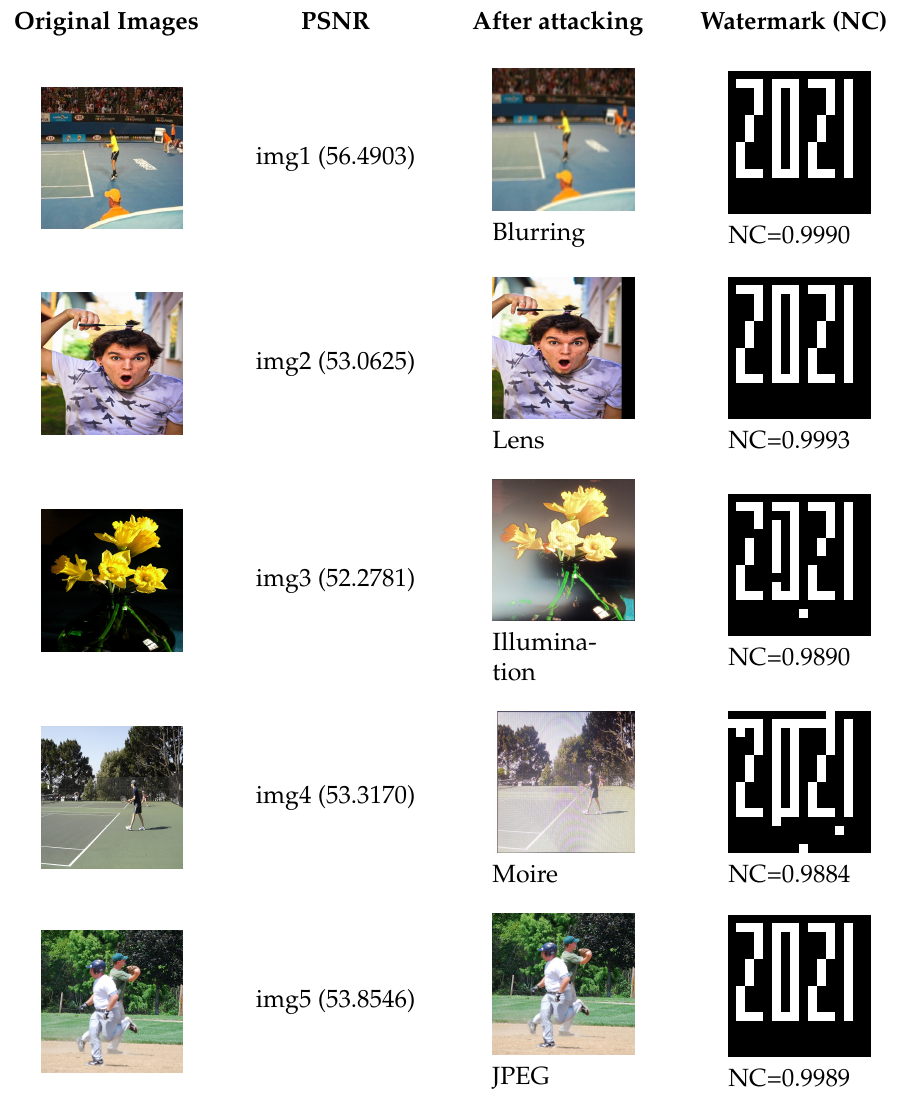
Figure 9. PSNR and NC values for different attacks.